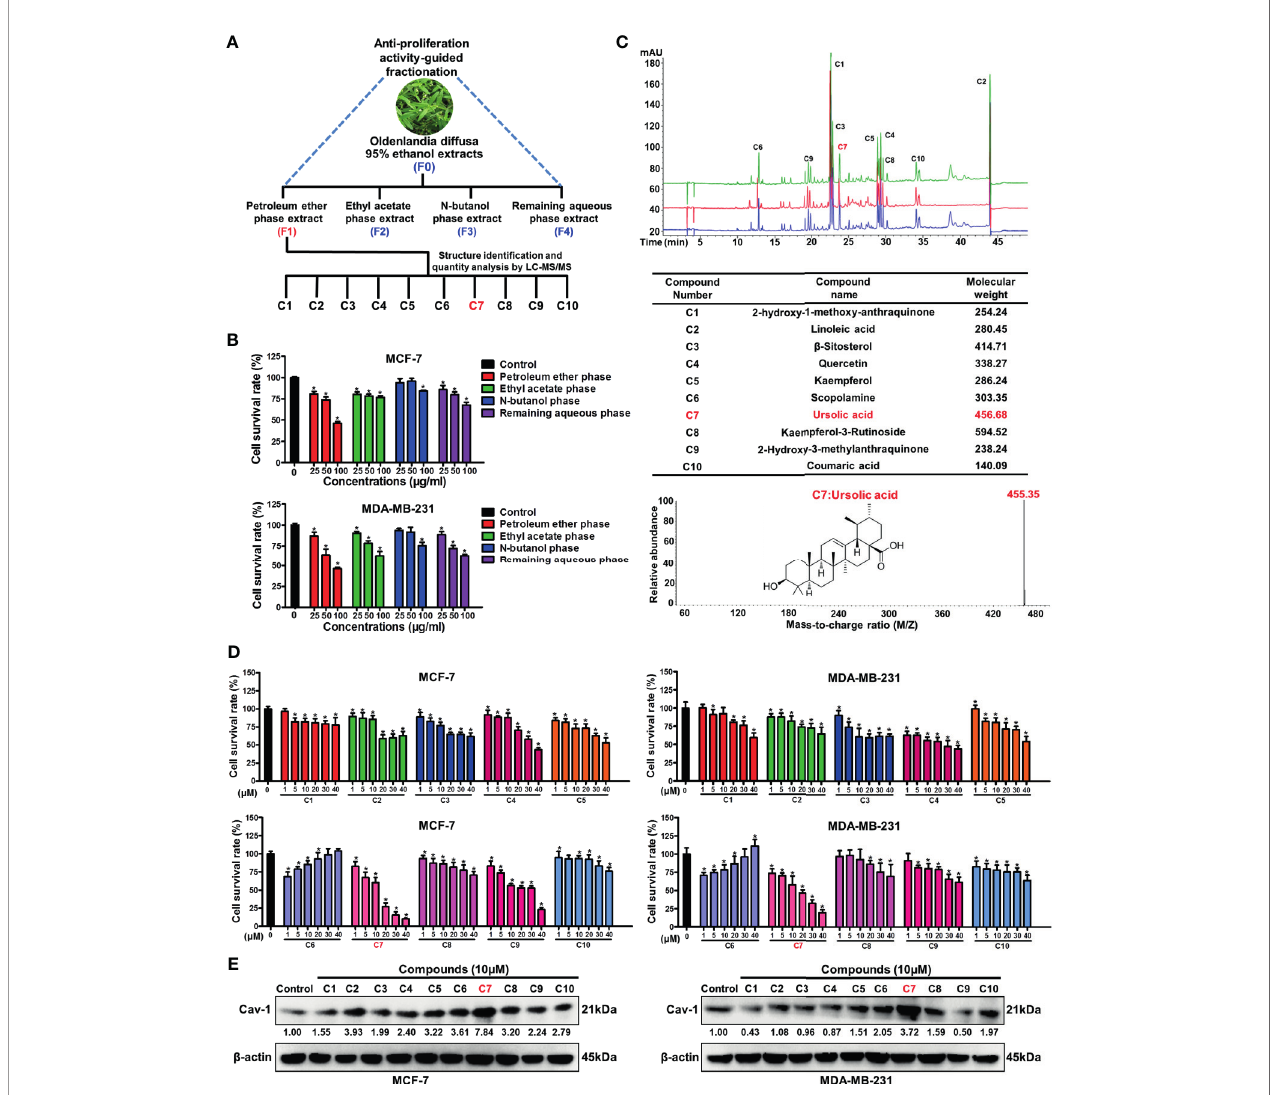
FIGURE 1 | Bioactivity-guided fractionation identi fi es ursolic acid as the bioactive compound of Oldenlandia diffusa against breast cancer. (A) Schematic illustration of the bioactivity-guided fractionation procedure. (B) MCF-7 and MDA-MB-231 cells were treated with different extracts of Oldenlandia diffusa (25~100 m g/ml) for 48 h CCK8 assay was conducted to investigate the survival rates of breast cancer cells. (C) The top 10 most abundant compounds in the F1 fraction were identi fi ed and quanti fi ed by LC-MS/MS. (D) MCF-7 and MDA-MB-231 cells were treated with 10 kinds of compounds (1~40 m M) for 48 h CCK8 assay was conducted to investigate the survival rates of breast cancer cells. (E) The expression change of Cav-1 protein in MCF-7 and MDA-MB-231 cells after treatment with 10 kinds of compounds (10 m M) for 48 h N = 3. * p <